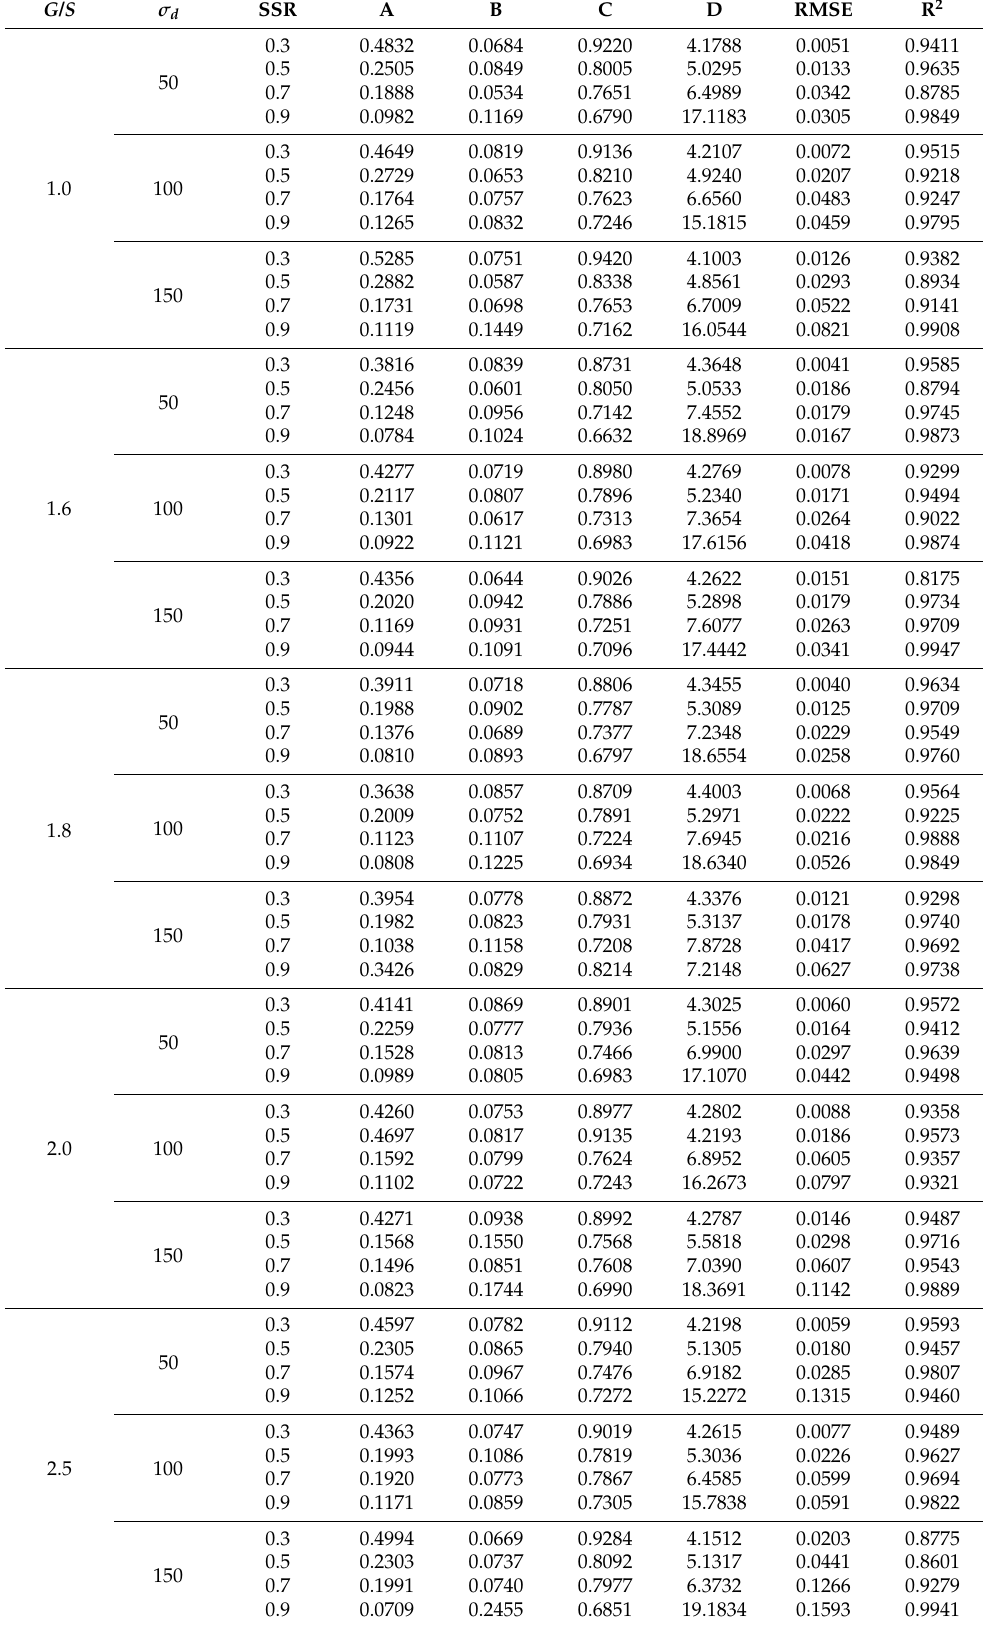
Table 4. Fitted model coefficients of the UIUC rutting